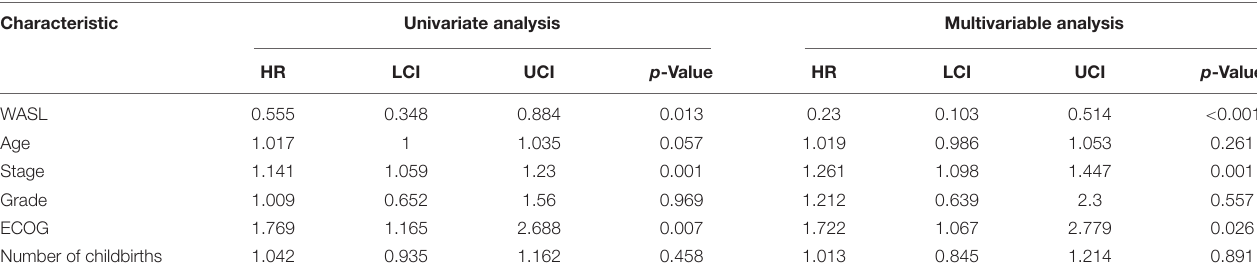
TABLE 2 | Univariate and multivariable Cox proportional hazards regression on the overall survival in TCGA-CESC. Characteristic Univariate analysis